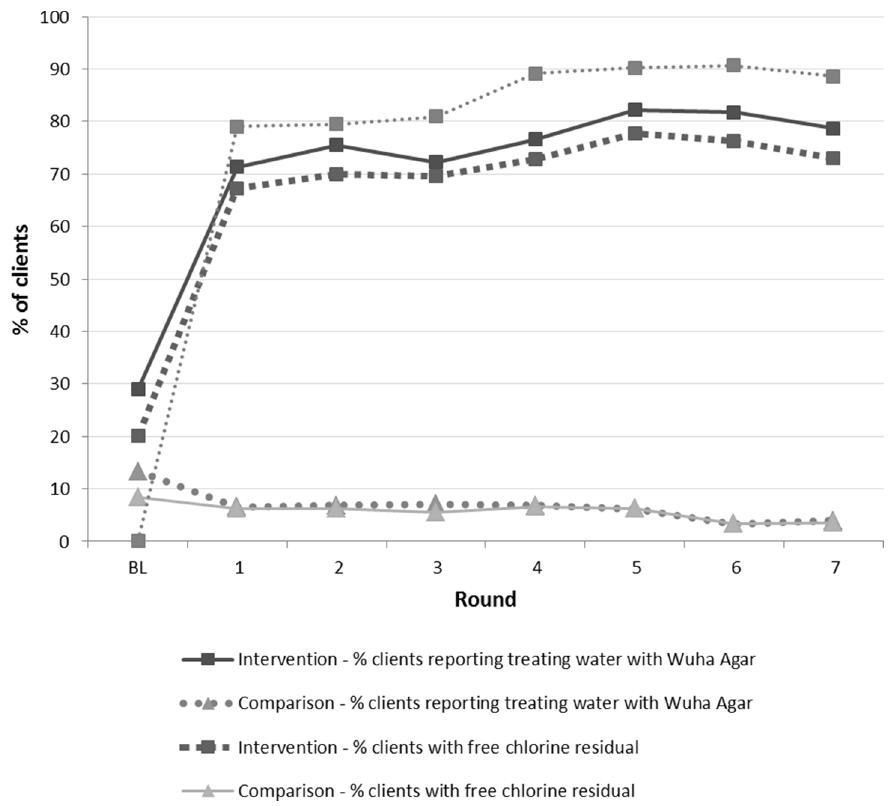
Figure 1. Percent of clients with reported water treatment with Wuha Agar, free chlorine residual in stored water, and observed BCP container, at baseline (before receiving the BCP) and by home visit round, by intervention and comparison group, basic care package evaluation, Gonder and Debre Markos, Ethiopia, October–January, 2010.